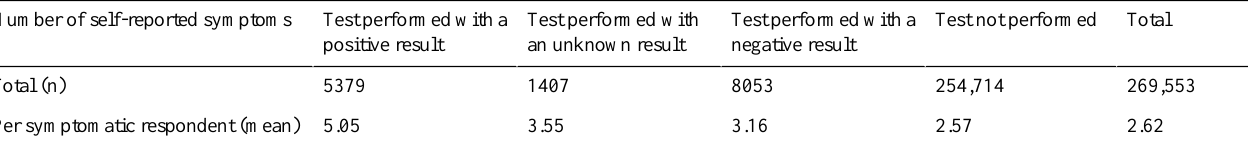
Table 2. Symptoms reported by survey respondents (n=102,973) and mean numbers of symptoms per symptomatic respondent based on molecular testing